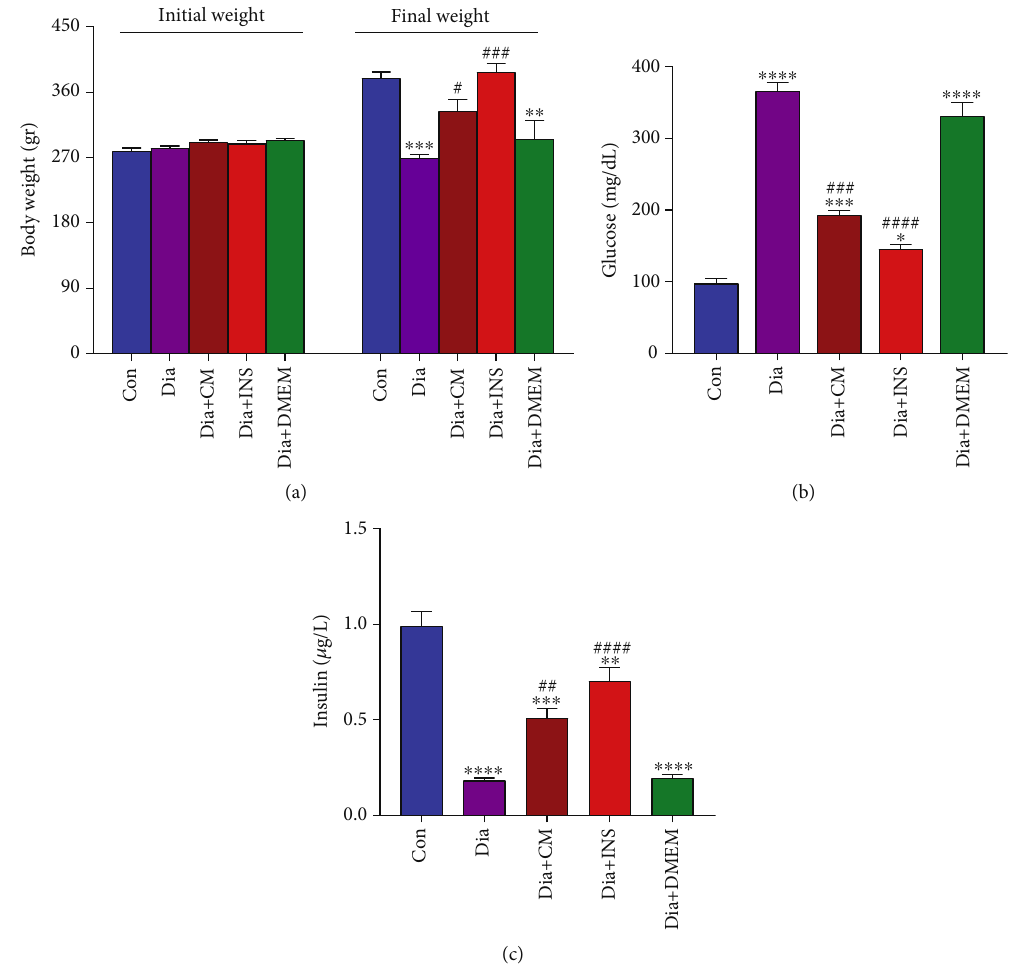
Figure 3: Body weight (a), blood glucose (b), and insulin (c) levels in the experimental groups. The values are presented as mean ± SEM ( n = 7 ). Signi fi cant di ff erences versus the control ( ∗ P < 0 : 05 , ∗∗ P < 0 : 01 , ∗∗∗ P < 0 : 001 , ∗∗∗∗ P < 0 : 0001 ) and diabetes rats ( # P < 0 : 05 , ## P < 0 : 01 , ### P < 0 : 001 , #### P < 0 : 0001 ). Con: control; Dia: diabetes; Dia +CM: WJMSC-CM-treated diabetic group; Dia +INS: insulin- treated diabetic group; Dia + DMEM: DMEM-treated diabetic